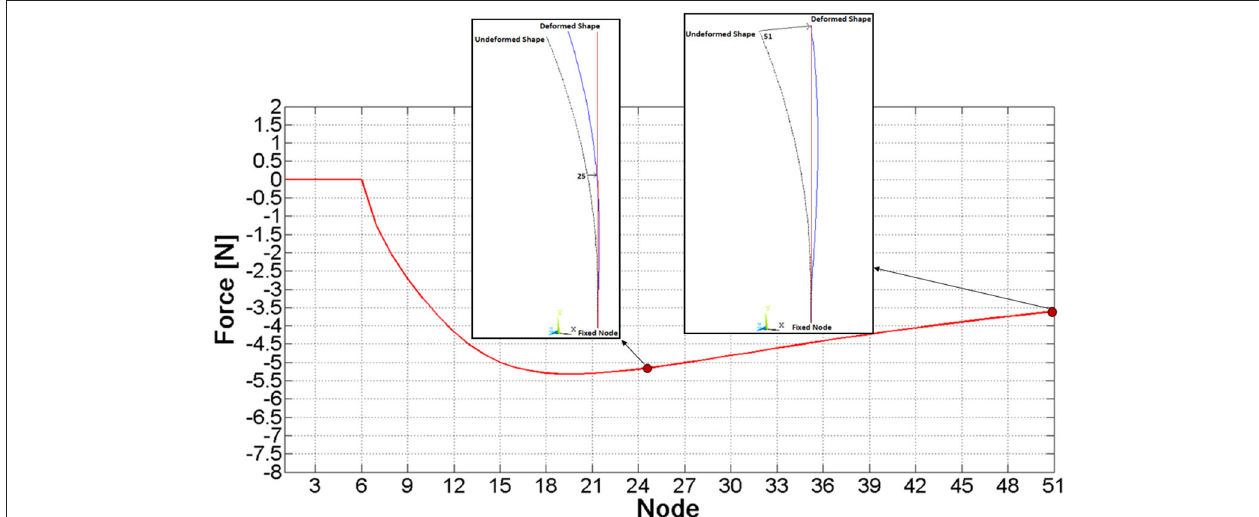
FIGURE 4 | Pattern of the force required to move a given node to the vertical axis.